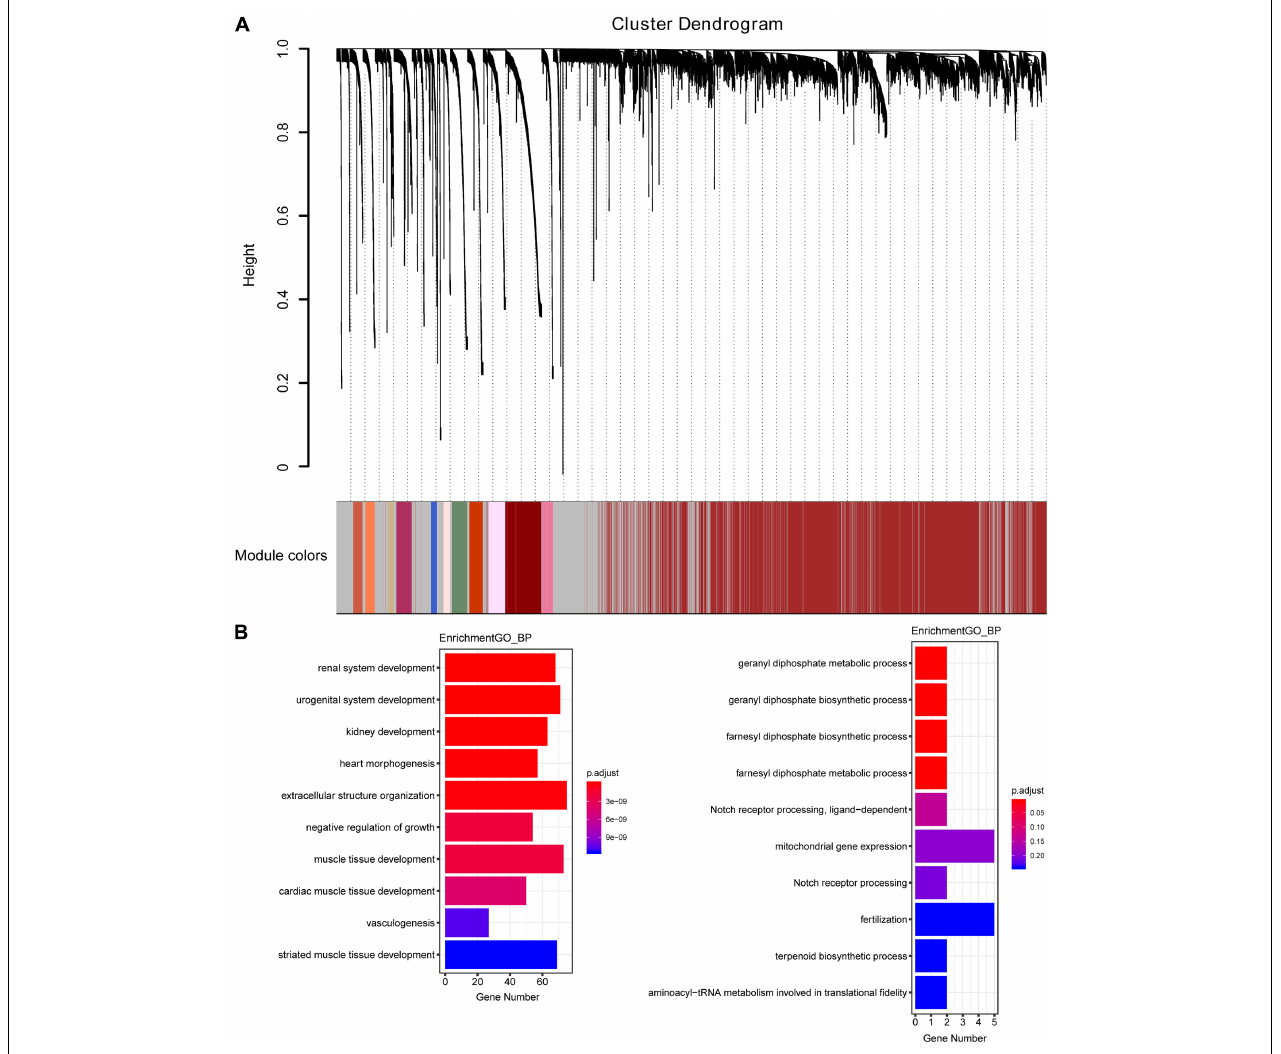
FIGURE 3 | The cluster dendrogram of the WGCNA co-expression network and functional enrichment of module genes. (A) Total genes were clustered in 176 modules. Each module was marked with one color. Except for the gray module, which included many unclassified members, the turquoise module contained a maximum of 4,594 members, while a minimum of 30 members were included in the dark sea green module. (B) GO analysis showed the top 10 enriched biological processes in the yellow (left panel) and medium orchid (right panel)